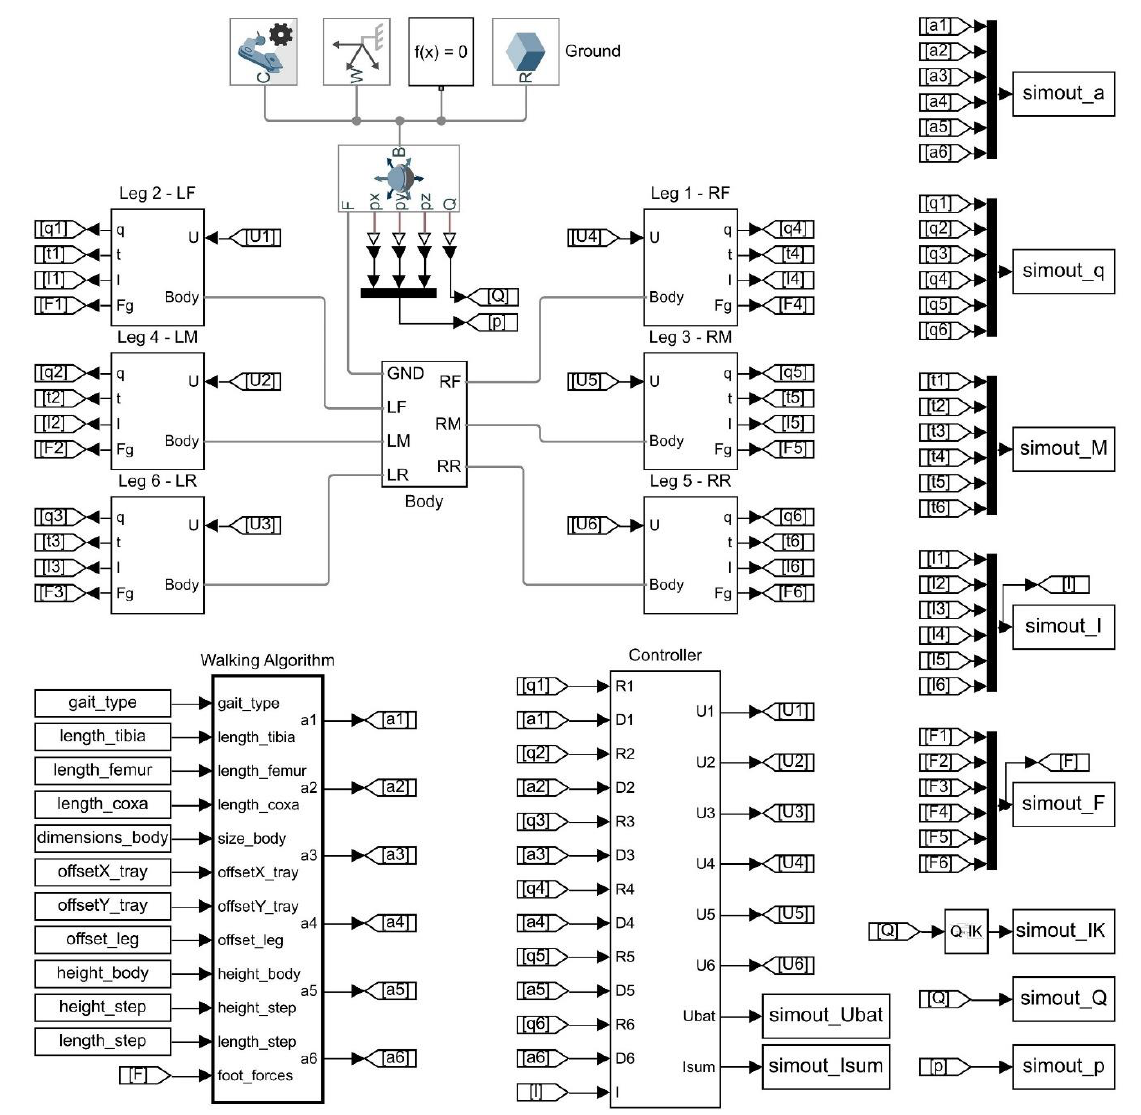
Figure 4. Multibody model of the Szabad(ka)-III robot. Table 2. Variable and fixed parameters of the model.